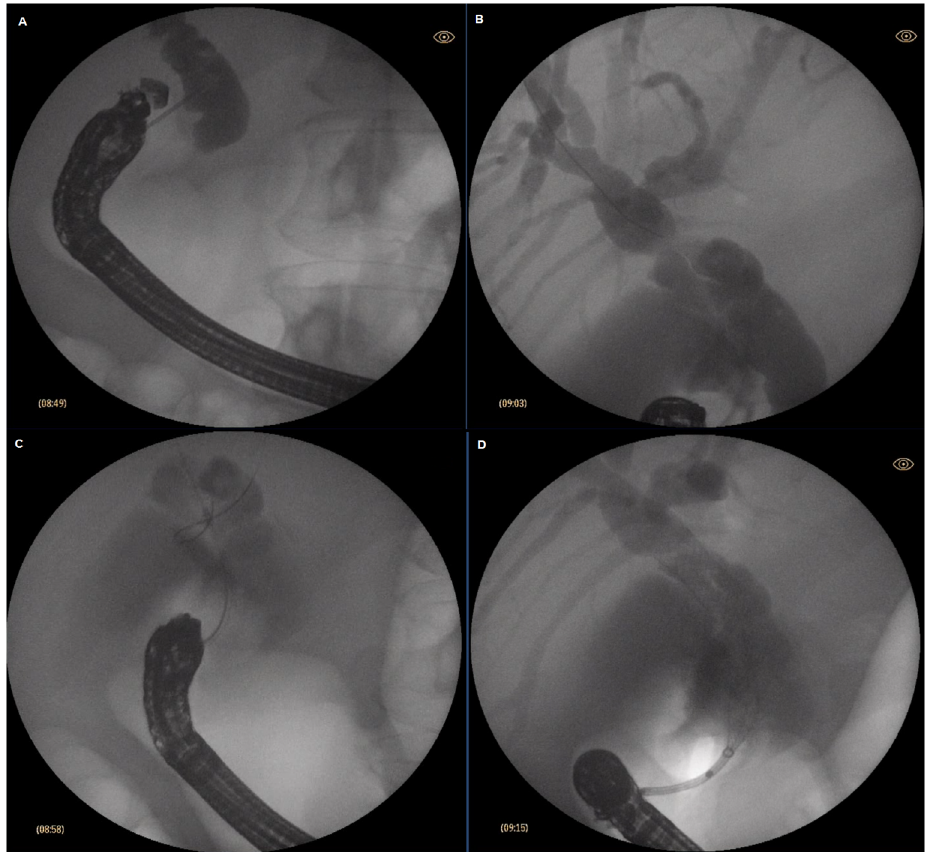
Figure 1. Stages of endocscopic ultrasound-guided choledochoduodenostomy (EUS-CDS); ( A ) puncture of the common bile duct (CBD); ( B ) advancement of the guidewire; ( C ) dilation of the fistulous tract; ( D ) stent insertion.